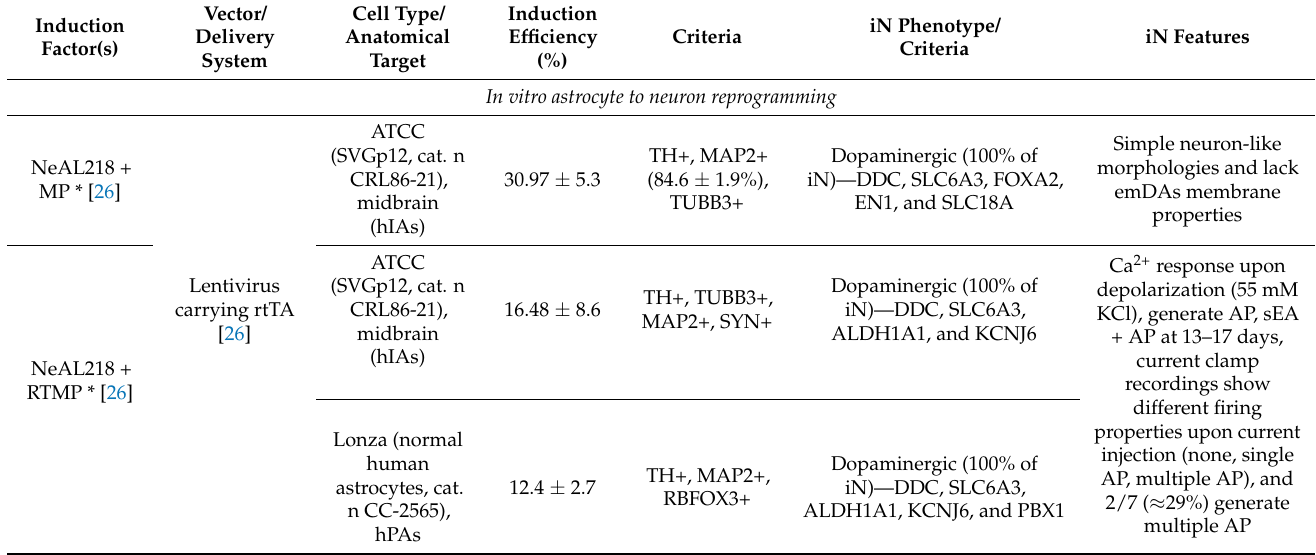
Table 2. Representative In Vitro and In Vivo Direct AtN Conversion and Reprogramming